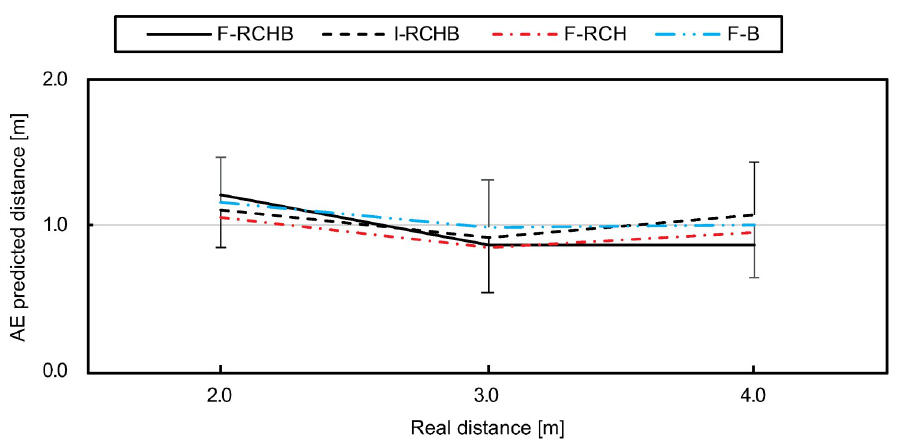
Fig 18. Absolute error. Mean and standard deviation of the absolute error of the predicted putting distance under the F-RCHB, I-RCHB, F-RCH, and F-B conditions.